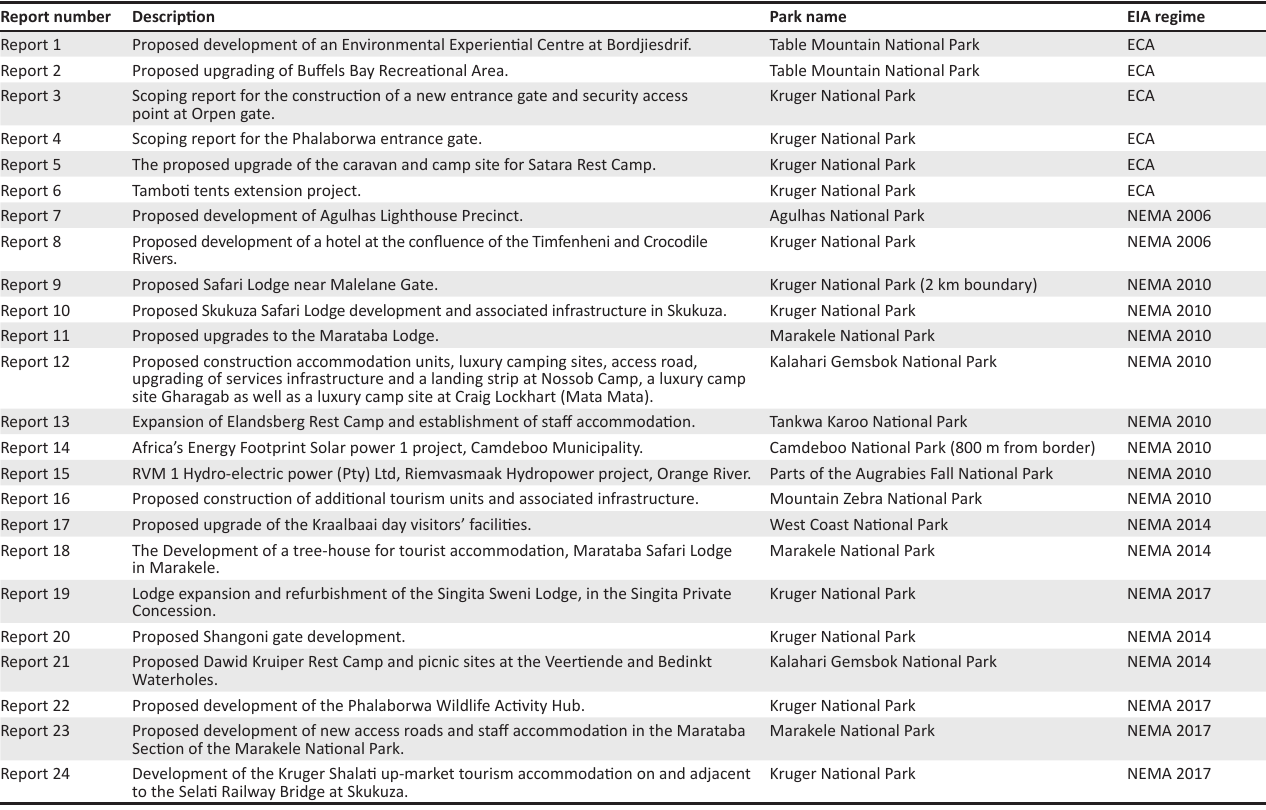
TABLE 1: Summary of Environmental Impact Assessment reports included in the evaluation.